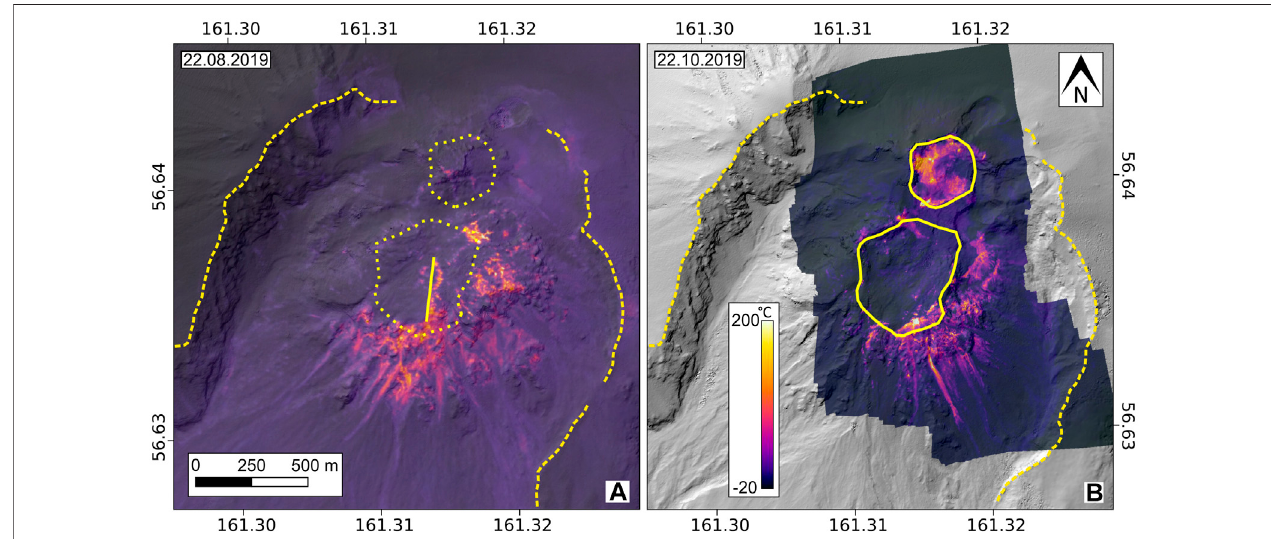
FIGURE 11 | Aerial FLIR data of the lava dome superimposed onto the DEMs of the pre-eruption survey on August 22, 2019 (A) and the post-eruption survey on October 22, 2019 (B) . While the southern side of the dome remained mostly intact and unchanged, the eruption was followed by a signi fi cant new anomaly in the northern part of the dome. The yellow lines in (B) outline new craters , and the dotted lines in (A) show the areas before these craters formed. The yellow dashed line outlines the 1964 amphitheater. The top of the dome is bisected by a N-S-striking anomaly shown with a solid yellow line in (A) in the area where the central crater was subsequently formed (B) . The scale bar maximum is 200 ° C because only a few local pixels signi fi cantly exceed this